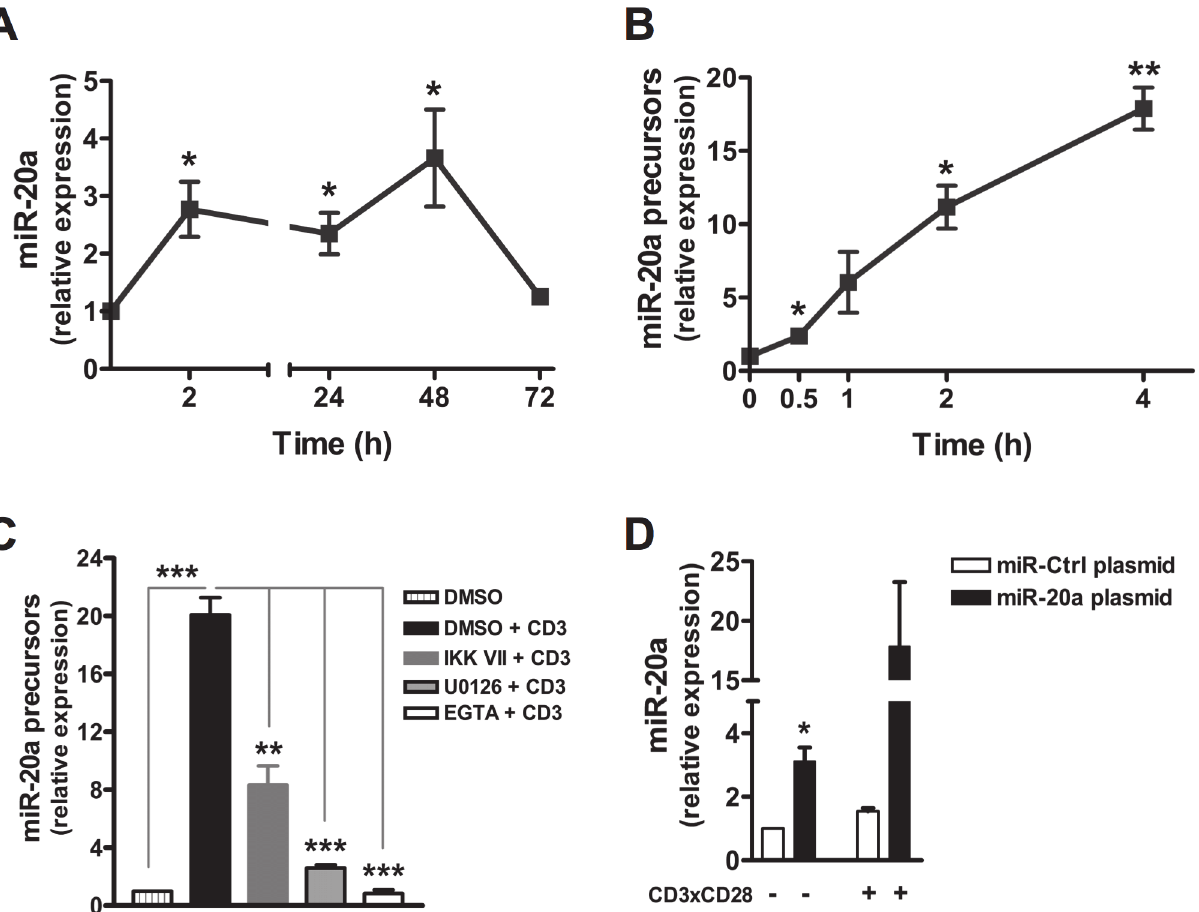
Fig 1. Expression of miR-20a and miR-20a precursors in human na ï ve CD4 + T cells. Human na ï ve CD4 + T cells were stimulated with plate-bound CD3 and CD28 mAbs for the indicated time periods. Quantification of (A) miR-20a and (B) miR-20a precursors (both pri- and pre-miRNAs) was performed using RT qPCR. (C) Na ï ve CD4 + T cells were also preincubated with DMSO, U0126 (10 μ M), IKK VII (200 nM) and EGTA (10 mM) for 30 minutes. Subsequently, samples were either left unstimulated or stimulated with plate-bound CD3 for 4 hours at 37°C. Expression of miR-20a precursors was quantified using RT qPCR. (D) Quantification of miR-20a level upon overexpression. Human na ï ve CD4 + T cells were transfected with plasmids encoding either miR-20a or miR- control (miR-Ctrl). Cells were either left unstimulated or stimulated for 2 hours with CD3xCD28 mAbs. Quantification of miR-20a in both resting and activated cells was performed using real-time PCR. Unless otherwise mentioned, all the data was normalized to either resting cells or unstimulated control transfected cells. Data represent arbitrary units ± SEM of at least 3 (A, C, D) and 2 (B) independent experiments. Significant P values were done by using Student ’ s t Test. ( * , P < 0.05; ** , P < 0.01; *** , P < 0.001).